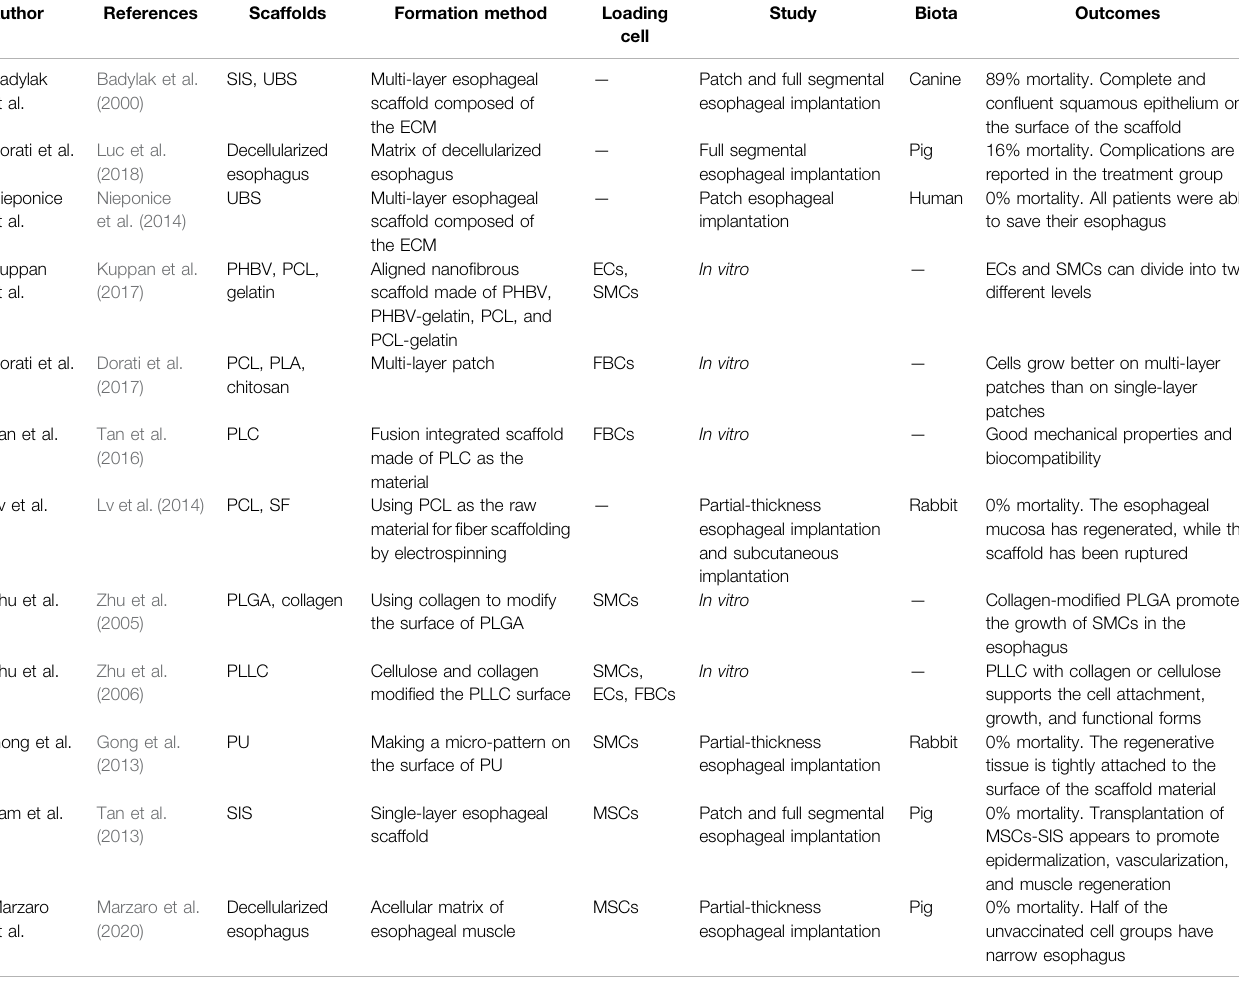
TABLE 1 | Classi fi cation according to materials of single-layer scaffolds.